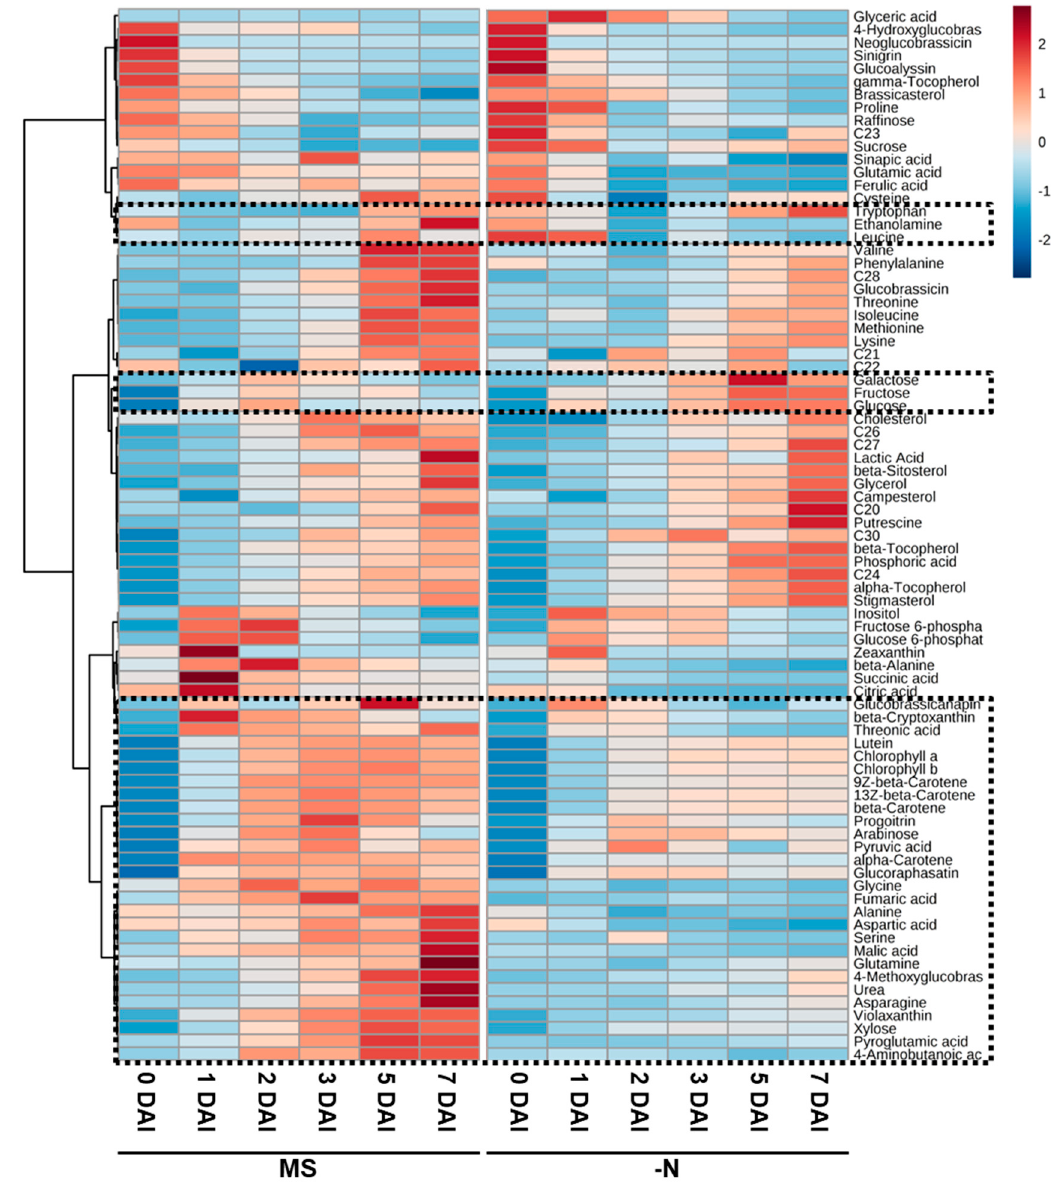
Figure 3. Heat map of differences in the contents of metabolites between radish sprouts grown under nitrogen sufficient (MS) and nitrogen deficient (–N) conditions. The average of standardized data is indicated in shades of red and blue for increase and decrease, respectively, in the metabolite content. DAI, day after light incubation began; C20, Eicosanol; C21, Heneicosanol; C22, Docosanol; C23, Tricosanol; C24, Tetracosanol; C26, Hexacosanol; C27, Heptacosanol; C28, Octacosanol; C30, Triacontanol.